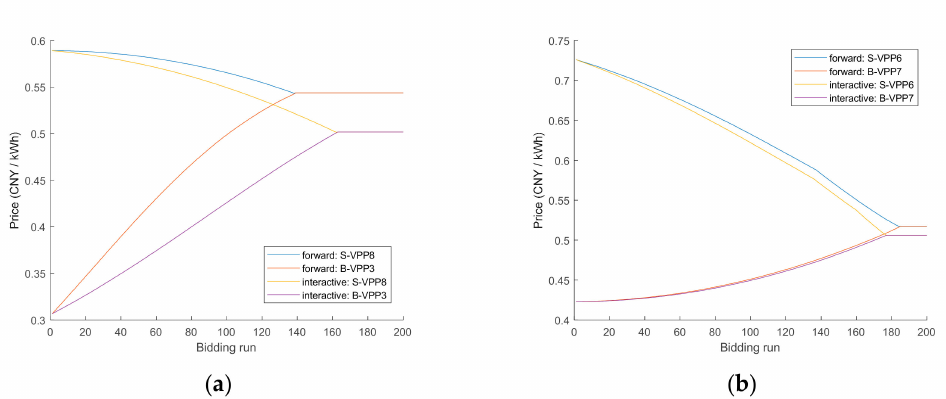
Figure 10. The price bidding process of P2P negotiation under two di ff erent mechanisms ( R = 1): ( a ) VPP 8 vs. VPP 3 , t = 1; ( b ) VPP 6 vs. VPP 7 , t = 2. Figure 10 shows the price bidding processes of two typical buyer–seller pairs in the P2P